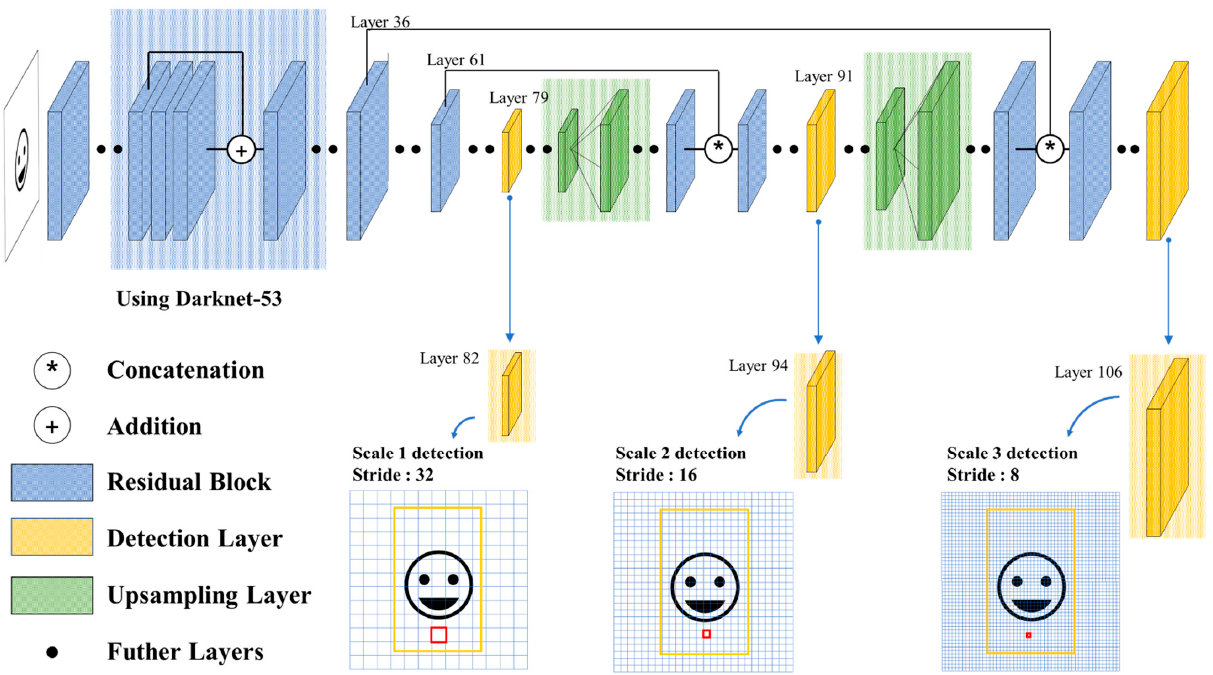
Figure 1. Conception of YOLO v3 network architecture.